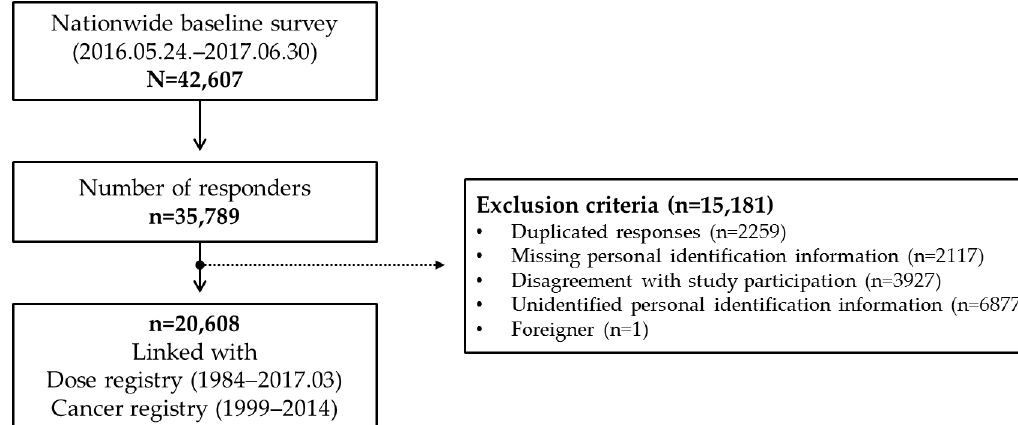
Figure 1. Enrollment of the study population.